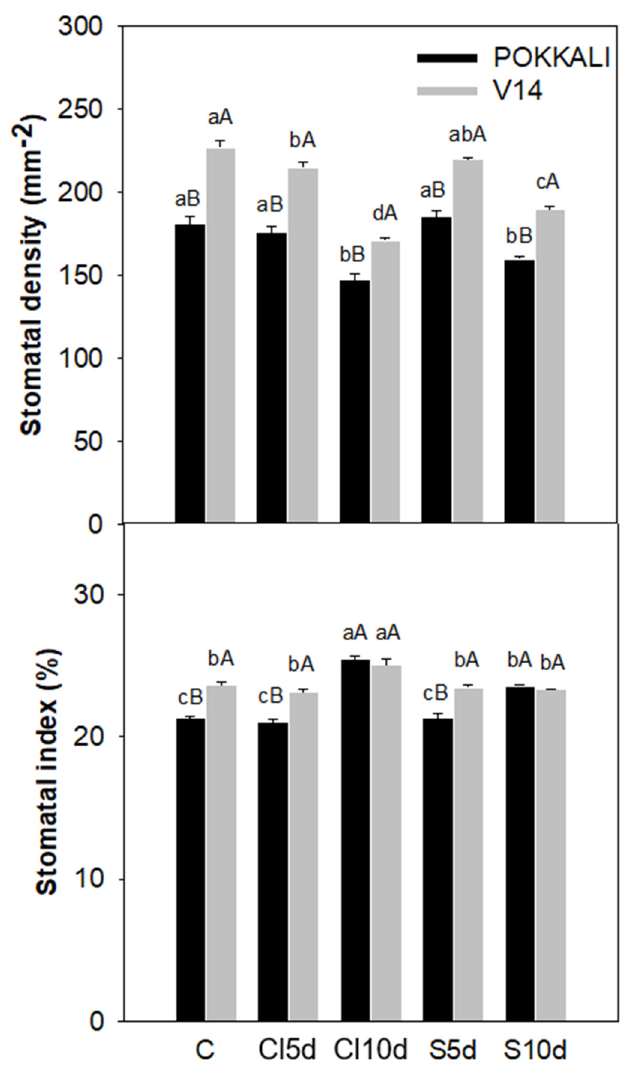
Figure 2. Comparisons of stomatal density and stomatal index in the flag leaf of rice control plants (C) and plants stressed by 5 dS m − 1 (5d) or 10 dS m − 1 (10d) of NaCl (Cl) or Na 2 SO 4 (S). Plants belong to two distinct cultivars (Pokkali: salt-resistant and V14: salt-sensitive). Each value is the mean of three replicates per treatment and vertical bars are standard errors of the mean. Treatments followed by the same lowercase letter for a particular cultivar do not differ statistically. Cultivars followed by the same uppercase letter in a particular treatment do not differ statistically.